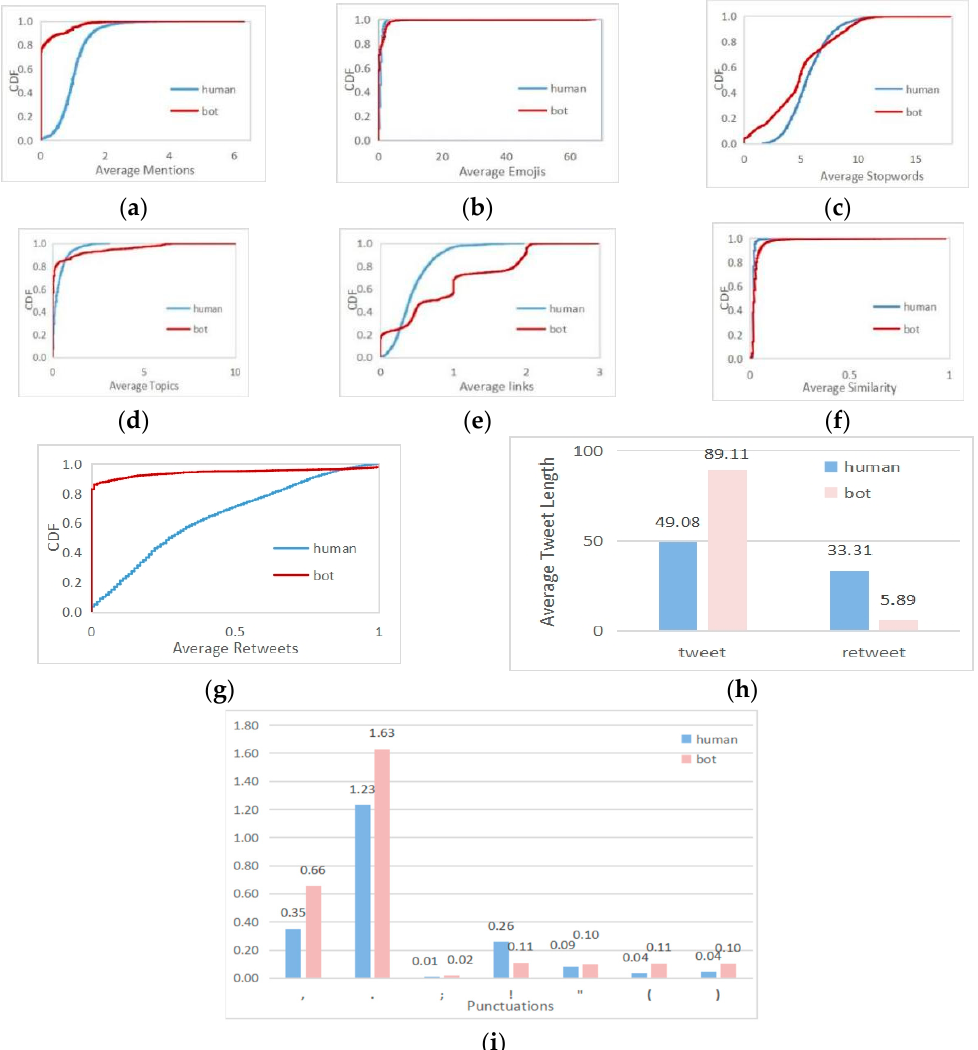
Figure 2. Feature analysis. ( a ) The cumulative distribution of the average mentions of tweets ( b ) The cumulative distribution of the average number of emojis used in tweets ( c ) The cumulative distribution of stop words ( d ) The cumulative distribution of topic participation ( e ) The cumulative distribution of link usage ( f ) The cumulative distribution corresponding to the proportion of tweet forwarding ( g ) The cumulative distribution function of the average similarity of tweets ( h ) Histogram of average length of original and forwarded tweets ( i ) Histogram of average number of the punctuations (“,”, “.”, “;”, “”“, “!”, “(“, and “)”).